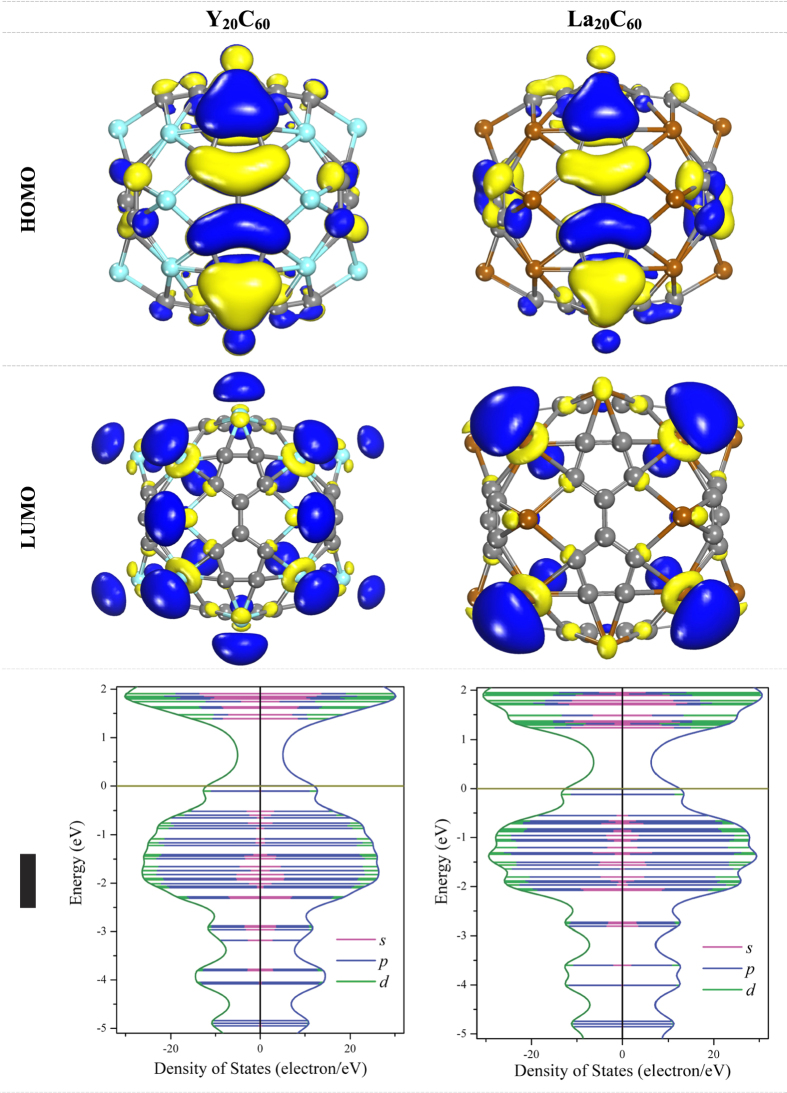
The HOMO and LUMO orbitals, and PDOS for M20C60 (M = Y and La).The isosurface for the orbitals is set at 0.015 e/Å3.